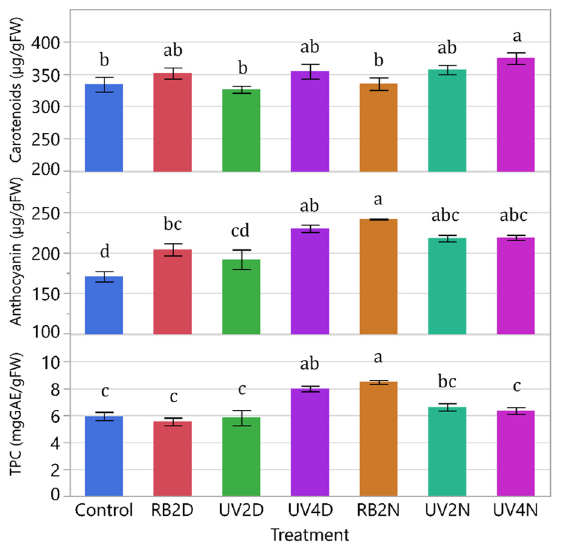
Figure 6. Total leaf area, specific leaf area (SLA), and relative chlorophyll content (SPAD), of the lettuce variety ‘Red Mist’ treated with pre-harvest supplemental UV-A/Blue (UV) or Red and Blue (RB) LED light for a duration of either two or four days (D) or nights (N), in a greenhouse hydroponic system (Experiment 2). The control plants did not receive any supplemental LED light. See Table 2 for treatment details. Means separated by different letters indicate significant differences according to Tukey’s HSD (honestly significant difference) test ( p < 0.05). Bars represent standard error.